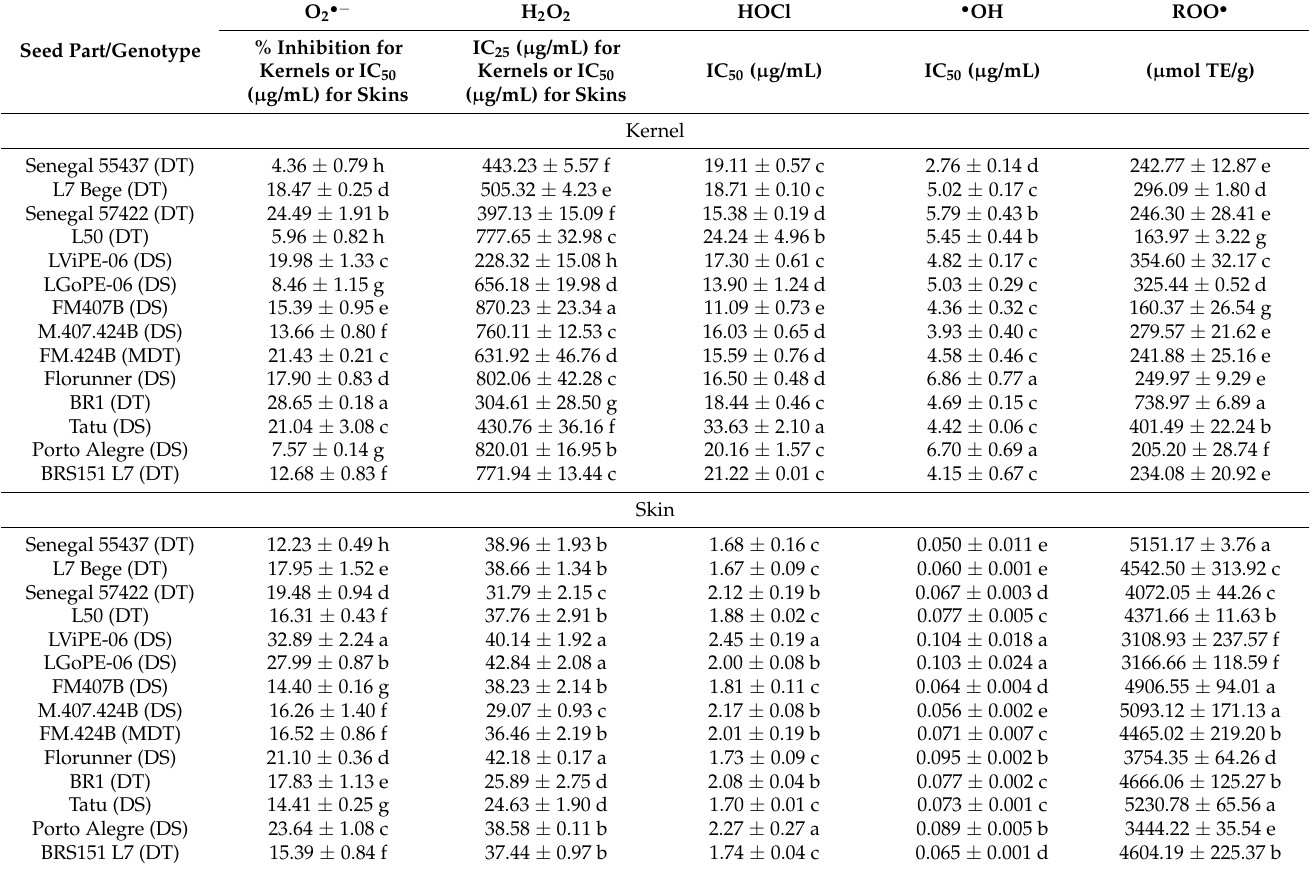
Table 4. Reactive oxygen species scavenging activities from optimized extracts of the skin and kernel of peanut genotypes with contrasting levels of tolerance to